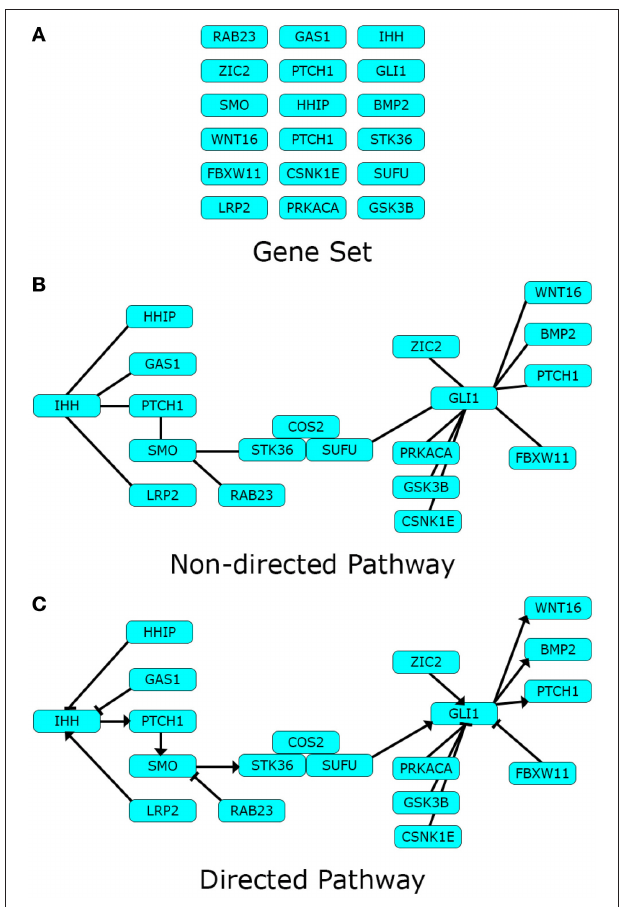
FIGURE 1 | Pathway data-types. Different types of pathway data can represent one pathway in different levels of detail. Here we use the Hedgehog signaling pathway modified from Kyoto Encyclopedia of Genes and Genomes (KEGG) as toy example. (A) Gene sets are lists of biological components pertaining a definite biological theme; while (B) Non-directed pathways describe the existence of definite interactions between the same components in the form of a network; finally (C) directed pathways disclose the character of the interactions in the network. Arrows depict an activating impact from the pointer component over the pointed one, and blunt edges an inhibiting